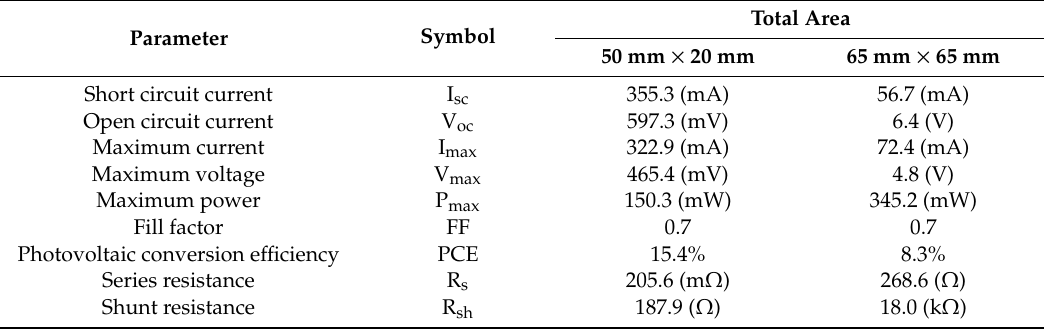
Table 1. Summary of average parameters from the silicon solar cells (modules)